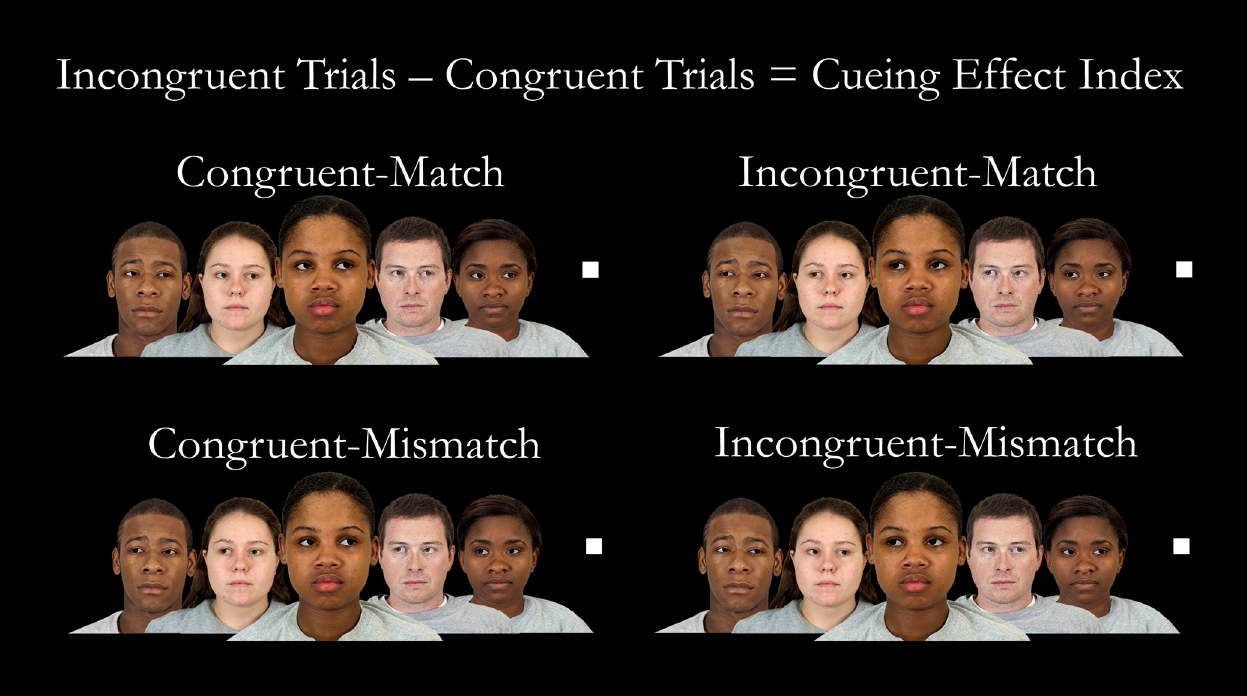
Fig 1. Types of trials in the multi-gaze cueing task. Note : The foreground gaze was either directed away from (incongruent, left column) or towards (congruent, right column) the target (white square), and either matched (top row) or mismatched (bottom row) background gaze cues. The cueing effect index was calculated by subtracting congruent from incongruent trial reaction times. Faces shown here are for illustrative purposes only (from the Chicago Face Database [22]) and do not reflect face stimuli from the multi-gaze cueing task. For actual faces used, see Cohen and colleagues’ paper [4].